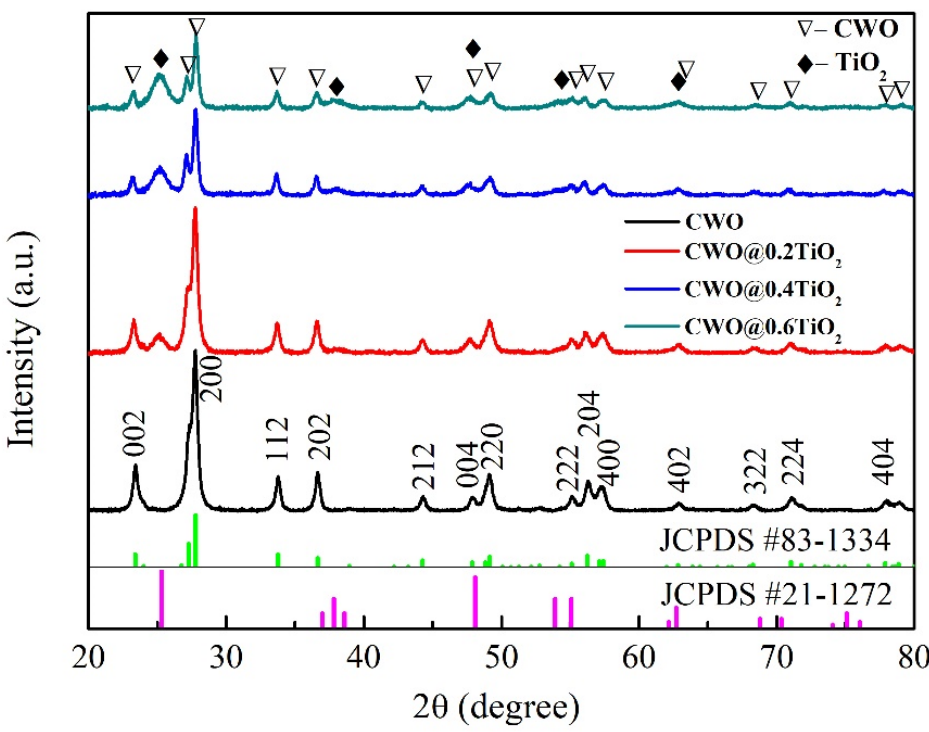
Figure 1. XRD patterns of the uncoated Cs x WO 3 and TiO 2 coated Cs x WO 3 nanoparticles.